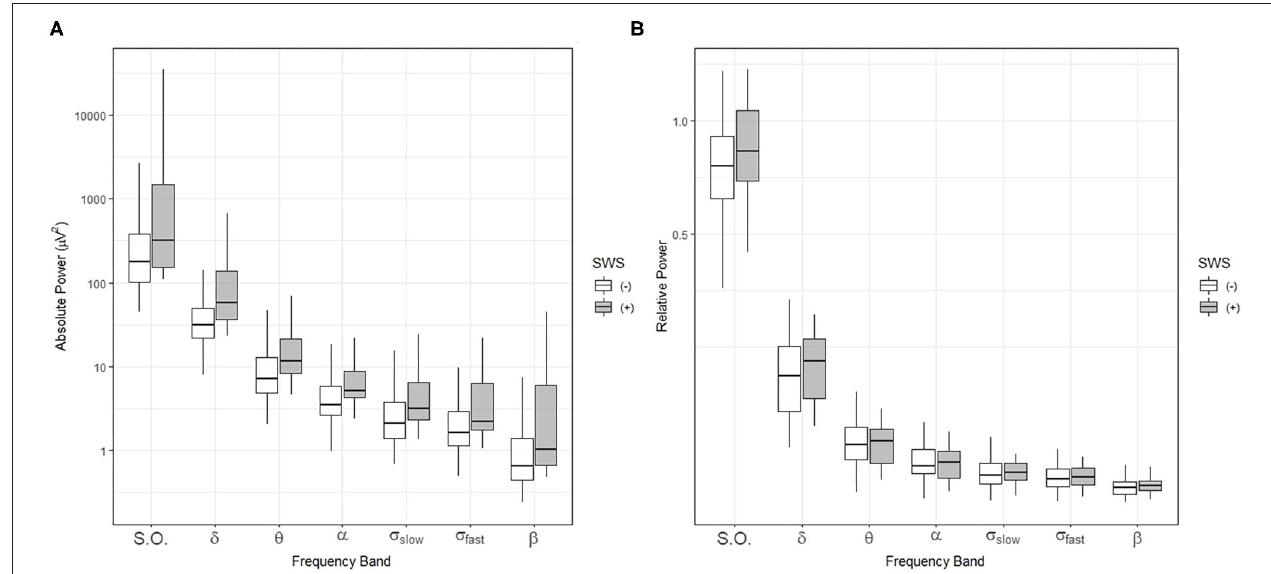
FIGURE 2 | Comparisons of sleep-related frequency bands over the entire sleep period in individuals with ( + ) and without (–) slow-wave sleep (SWS). Box-and-whisker plot of absolute power (A) and relative power (B) during NREM sleep for the whole night. SWS ( + ): participants with slow wave sleep, SWS (–): participants without slow wave sleep, S.O.: slow oscillation (0.5–1Hz), δ : delta (1–4Hz), θ : theta (4–8Hz), α : alpha (8–12Hz), σ slow : slow sigma (12–13.5Hz), σ fast : fast sigma: (13.5–15Hz), β : beta: (15–20Hz).